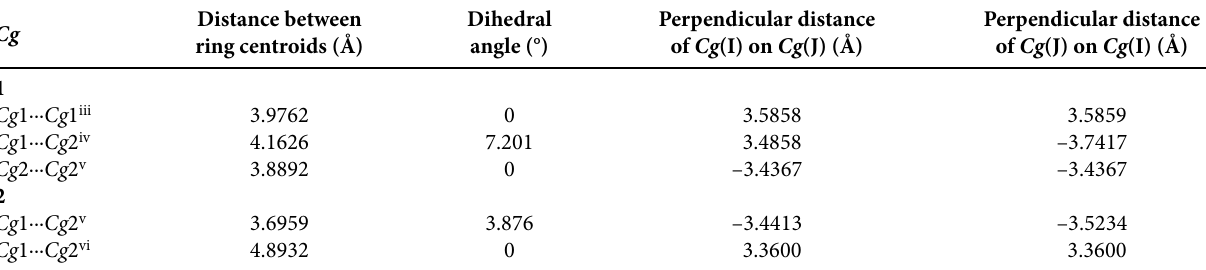
Table 4. π – π interactions